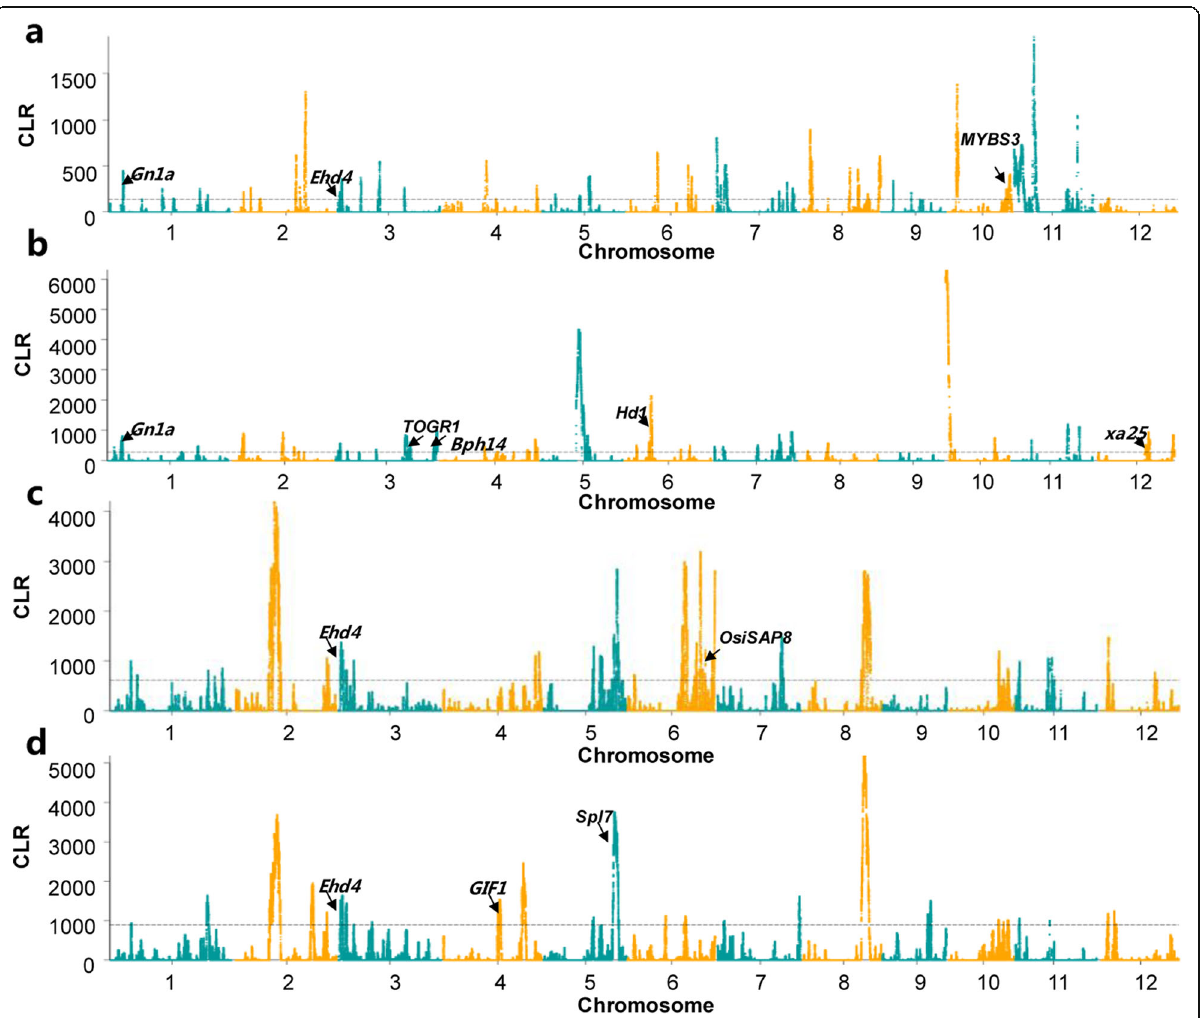
Fig. 5 Genomic regions with strong selective-sweep signals in subgroup Jap-N ( a ), Jap-S ( b ), Ind-N ( c ) and Ind-S ( d ),